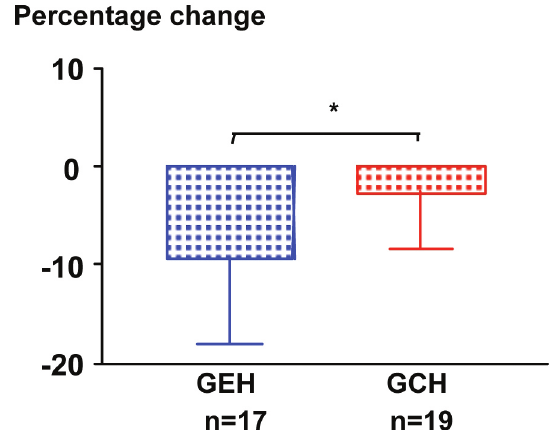
FIGURE 2 - Percentage change ± SD of diastolic arterial pressure between time 0 and the arithmetic mean of the measures after 120, 180 and 270 days in the hypertensive experimental group (EGH) and hypertensive control group (CGH). *p=0.01EGH n=17 (17 patients in EG with SAP above 90 mmHg on the 1st AP measure); CGH n=19 (19 patients of CG with DAP above 90 mmHg on the 1st AP measure).